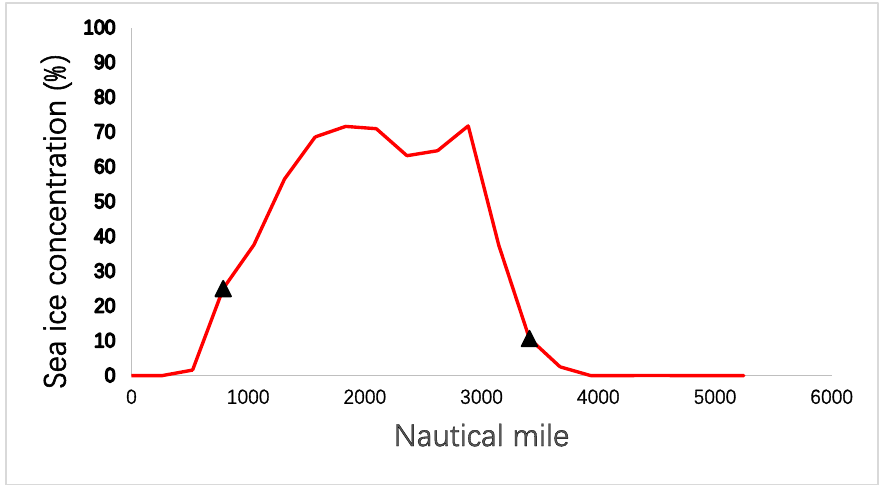
Figure 5. The overall sea ice concentration of the NEP from 2000 to 2019; the black triangles indicate the start and end positions of the ice segment. Figure 6 reveals the navigation window information of the NEP from 2000 to 2019.